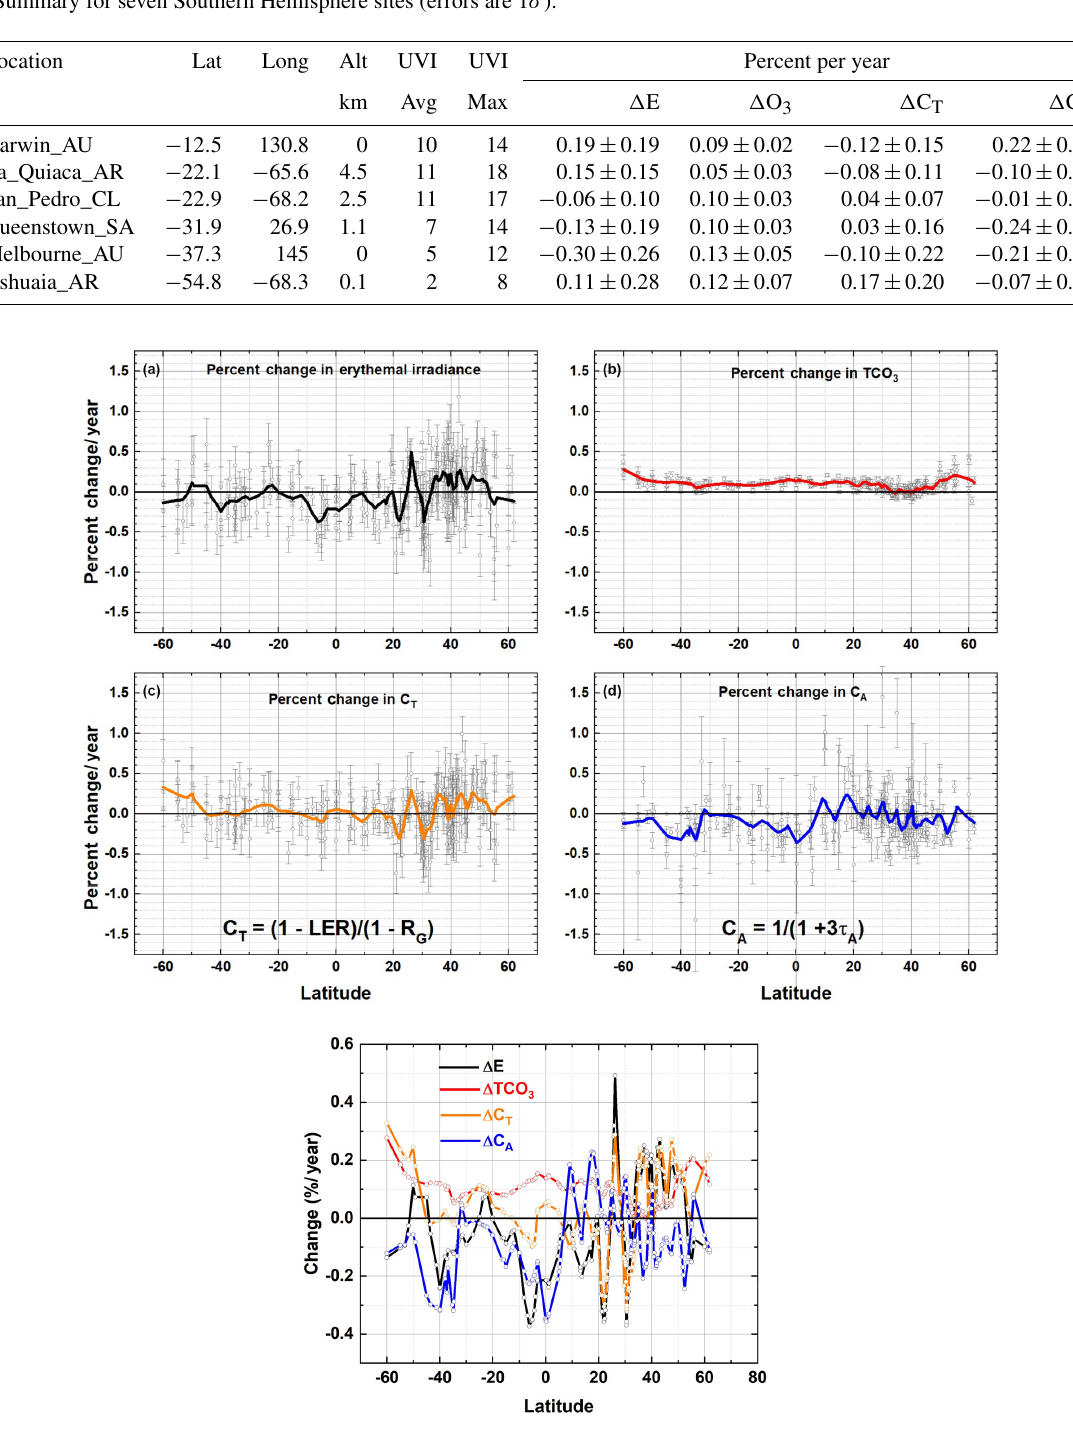
Figure 7. (a) Percent change per year for (a) erythemal irradiance (cid:49) E, (b) (cid:49) TCO 3 (total column ozone) for the period 2005–2018, (c) (cid:49) C T (atmospheric transmission), and (d) (cid:49) C A (absorbing aerosol transmission) from OMI observations at individual sites (see Table A4). The solar cycle and quasi-biennial oscillation effects have not been removed. Error bars are 1 σ . Solid curves are Loess(0.1) fits to the data (15 ◦ averaging) and are shown in Fig. 7b with the same color code. A geographic map of the land locations in Table A4 and Fig. 7 is shown in Fig. A3. (b) Loess(0.1) fits from Fig. 7a showing the correlation of (cid:49) E with (cid:49) C A and (cid:49) C T and anticorrelation with (cid:49) TCO 3